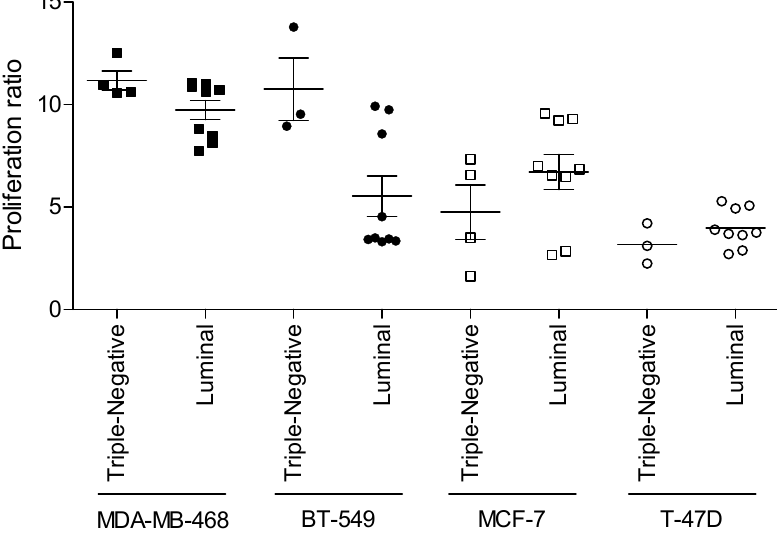
Figure 5. Effect of WHF originating from triple-negative or luminal breast cancer surgery on proliferation of triple-negative- or luminal-subtype breast cancer cells. The TN breast cancer cell lines MDA-MB-468 and BT-549 and the luminal breast cancer cell lines MCF-7 and T-47D were starved for 24 h (0% FBS) and then treated for 96 h with 1% WHFs from patients bearing TN or luminal breast cancer. WHF-induced cell growth was analyzed according to resected breast cancer subtype. The ability of WHF to induce proliferation was indicated as the ratio of the OD of each cell line (WHF-treatedat 96 h/OD at 0%, before treatment).